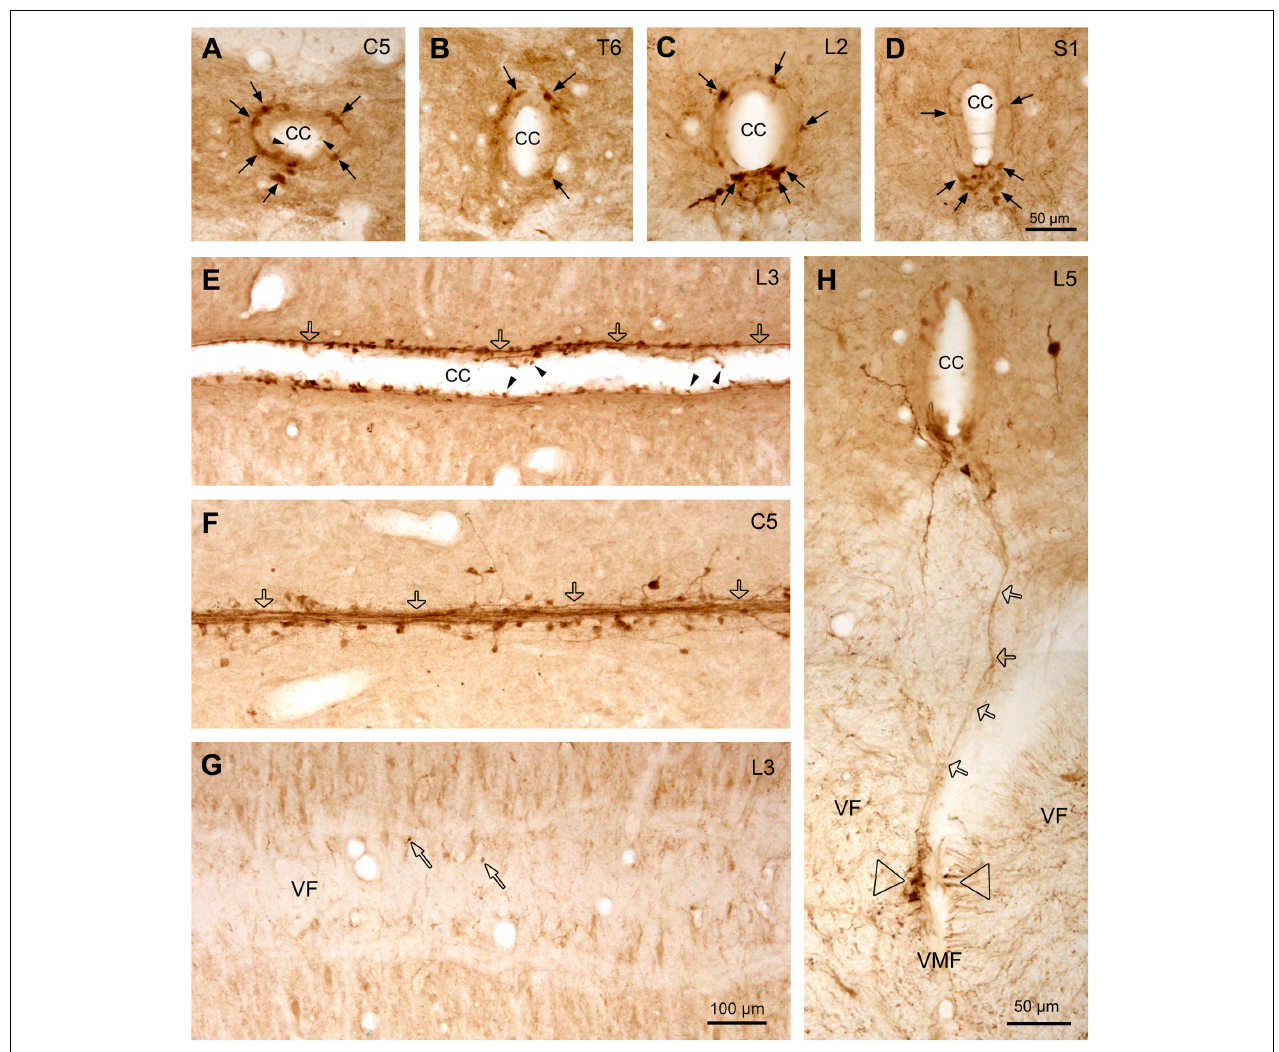
FIGURE 7 | Aromatic L -amino acid decarboxylase cells and fibers/fiber bundles around the CC. (A–D) AADC cells around the CC from C (A) , T (B) , L (C) , and S (D) segments illustrated in transverse sections. Dorsal side is upward for all the sections. It is clear that at C and T spinal levels the AADC cells were distributed evenly around the CC in different directions, whereas at the L and S levels, especially at S level, the AADC cells were mainly located ventral to the CC although a small number of the cells could also be observed in other parts (arrows). (E,F) AADC cells and fibers/fiber bundles lateral to the CC (E) and just at the bottom of the CC (F) seen in horizontal sections. It seems that the fibers arising from the AADC cells joined together to form fiber bundles (hollow arrows) which run longitudinally along the CC, yielding garlic braid-like chains. (G) Image from a horizontal section just below the CC showing that only a few AADC-IR puncta are apparent (narrow hollow arrows) in VF, indicating that most fibers from the AADC cells around the CC do not project toward the VMF. (H) Image from a transverse section showing a AADC-IR fiber/fiber bundle (hollow arrows) ran all the way from the ventral side of the CC to the left side of the VMF, where a cluster of AADC-immunoreactive fibers is apparent (hollow triangles). This fiber/bundle might be originated from an AADC cell(s) around the CC but it is hard to pinpoint its originating cell body in this section. In some sections, e.g., in (A) and (E) , clear swellings at one end of the AADC cell processes could be seen to protrude into the lumen of the CC (arrowheads). The spinal segment level is indicated at upper right corner in each panel. AADC antibody was from rabbit. Scale bar in (D) , valid for (A–D) , and in (H) , 50 µ m; in (G) , valid for (E–G) , 100 µ